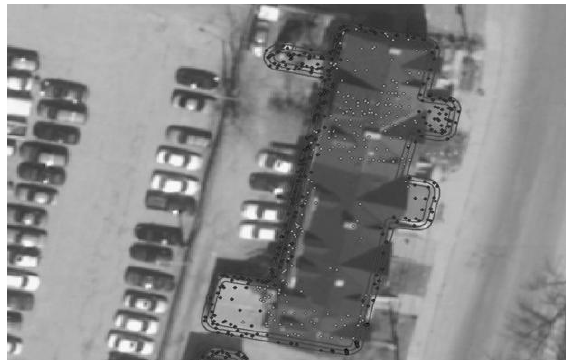
Figure 7. Using 3.5 m as cutoff on large houses points out the discrepancy between the building outline and its aerial photo: the building outline near the upper central part on the photo shows an thin extension formerly belonging to some structure that no longer existed at the time the photo was taken. Using only the out-of-date roofprint would lead to selection of some LiDAR data as legitimate